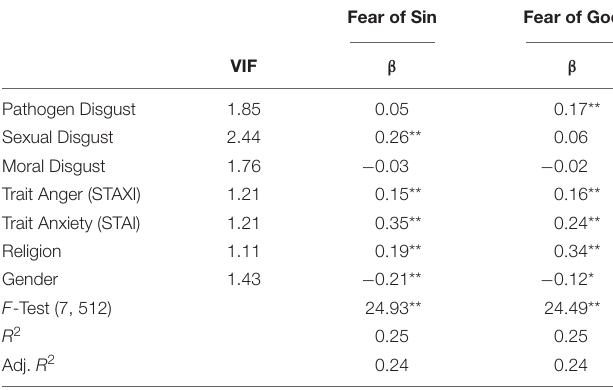
TABLE 2 | Religious scrupulosity linear regressions the variance inflation factors (VIF) are also shown.